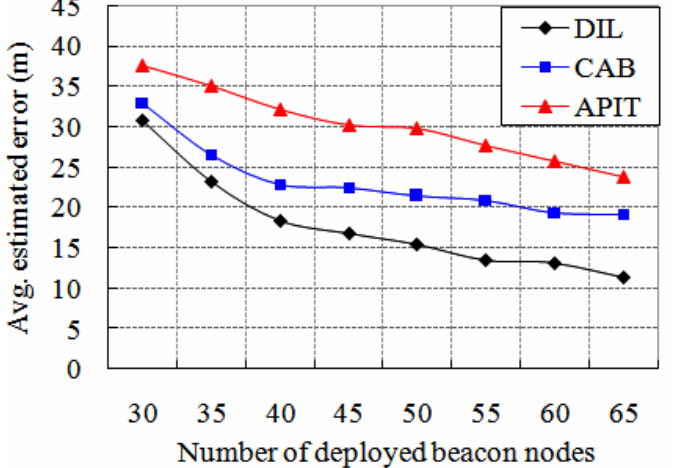
Figure 12. Comparison of average estimated localization error for different number of beacon